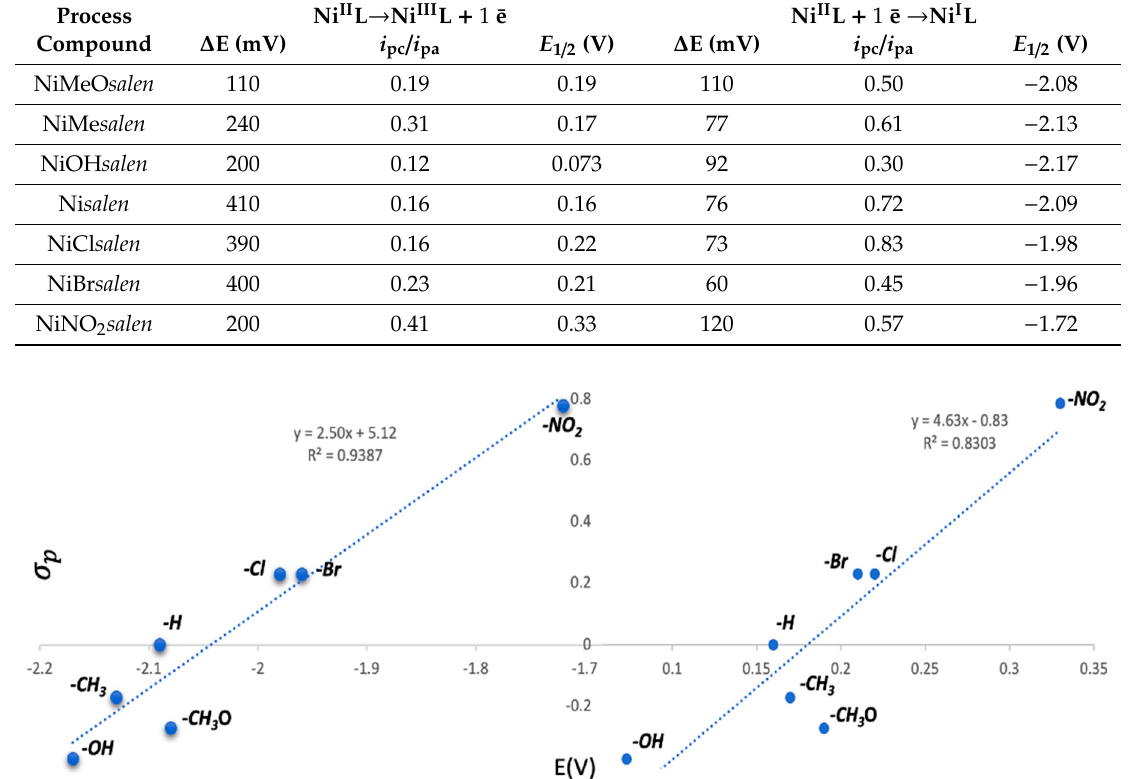
Figure 13. Left: correlation between E 1 / 2 of Ni II / Ni I and the σ p constant for the NiR salen complexes. Right: correlation between E 1 / 2 of Ni III / Ni II and the σ p constant for the NiR salen complexes.